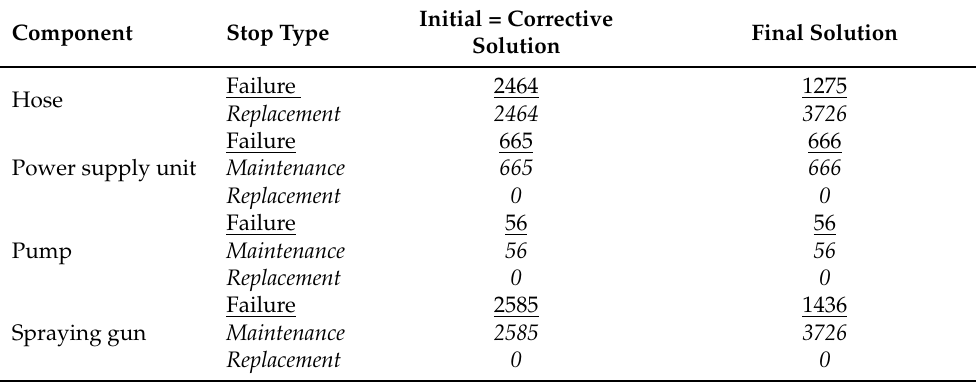
Table 6. Numbers of stop instances yielded from training the model for the spraying cabin (GORENJE) within the simulation interval (200 years). Underlined and italic contents correspond to failures and strategies, respectively.